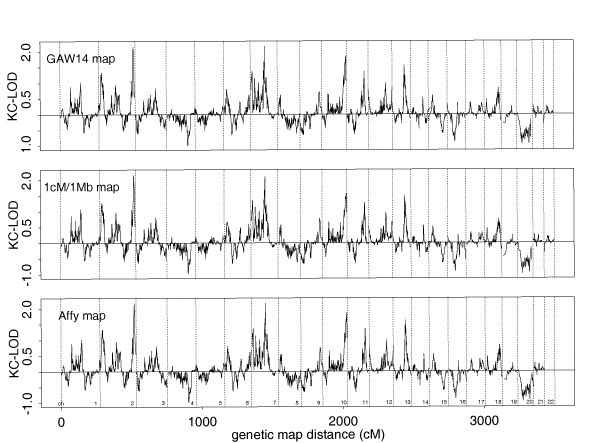
K-C LOD scores for NPLall for the Affymetrix SNP markers. Three sets of results are included: one using the genetic map given by Affymetrix (G. Kennedy, personal communication), one using the map derived from the 1 Mb-to-1 cM rule, and another using the genetic map given by GAW14.